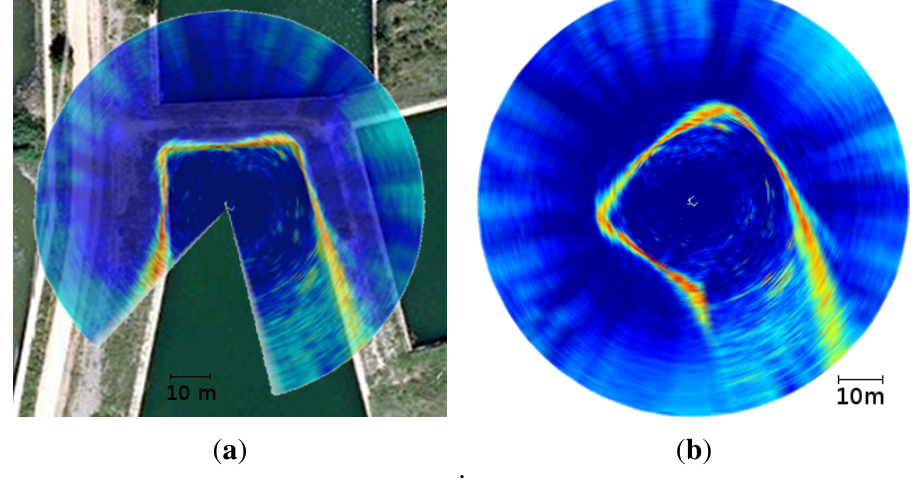
Figure 2. ( a ) A scan as it should look like, overlaid to a satellite view of